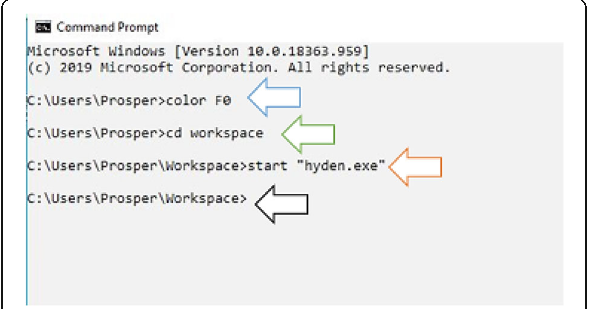
Fig. 7 Graphical representation of command actions for degenerate primer design. The arrows show the directory path to the working folder and start-up of the hyden program. The command-line color F0 illustrated by the blue arrow in this figure changes the background of the command prompt as white and the foreground as black. cd workspace changes the directory into the workspace folder as depicted by the green arrow. The orange and black arrow illustrates the opening of the hyden executable